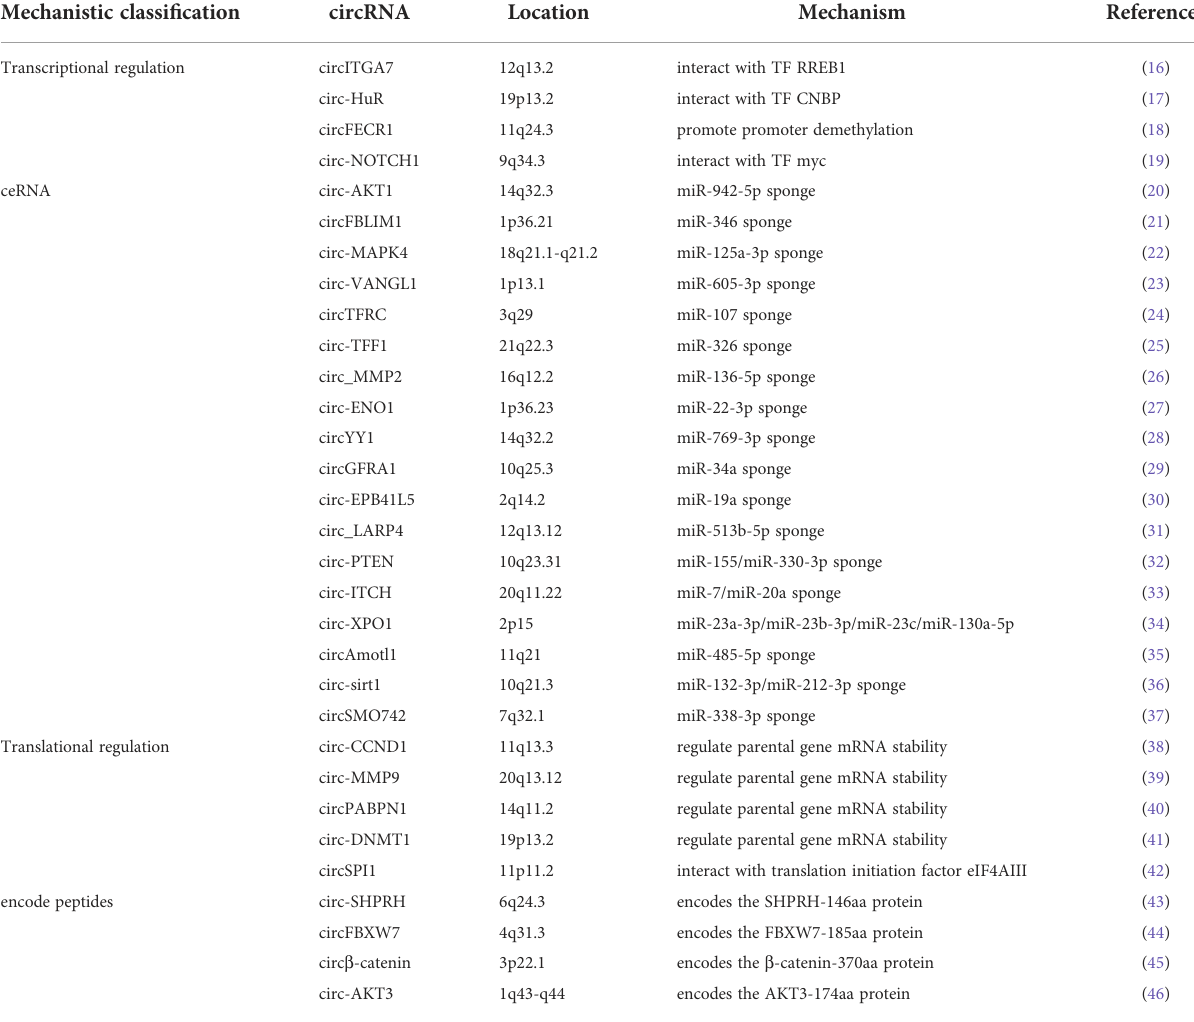
TABLE 1 The mechanisms of circRNAs regulate parental gene expression. Mechanistic classi fi